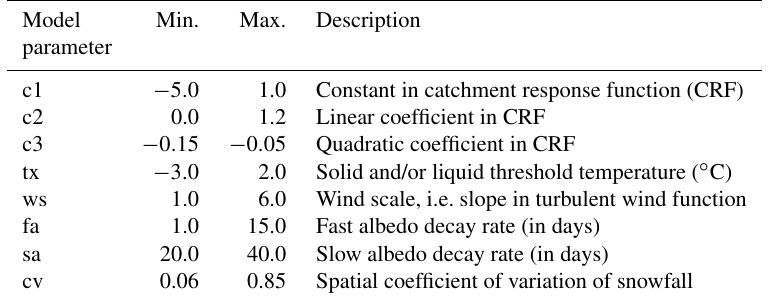
Table 2. Range of model parameters used for the PT_GS_K model uncertainty